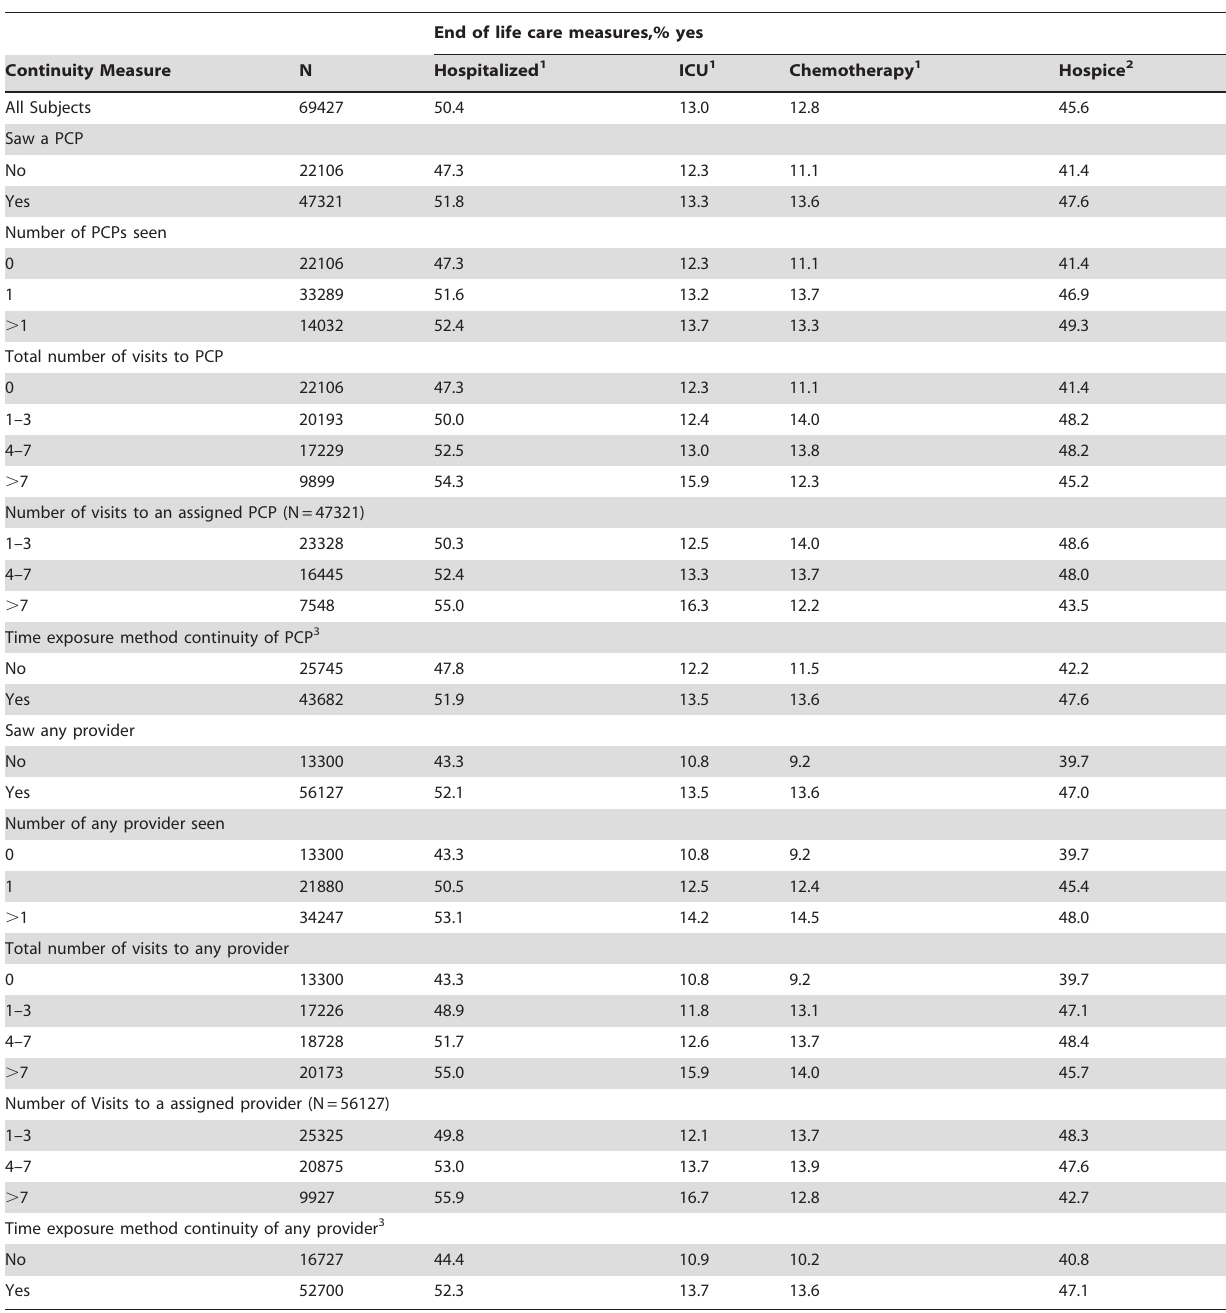
Table 2. Provider continuity in the year prior to diagnosis of advanced lung cancer and end-of-life care.